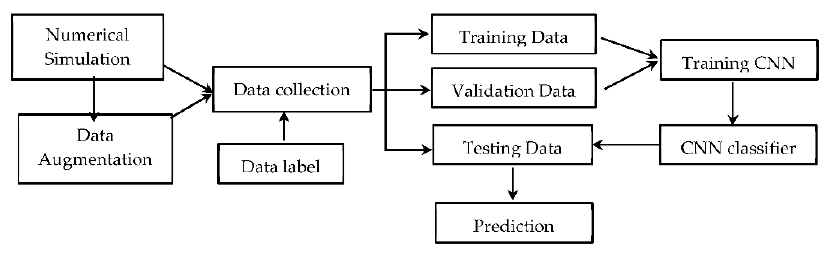
Figure 8. Flowchart for damage detection using the CNN.